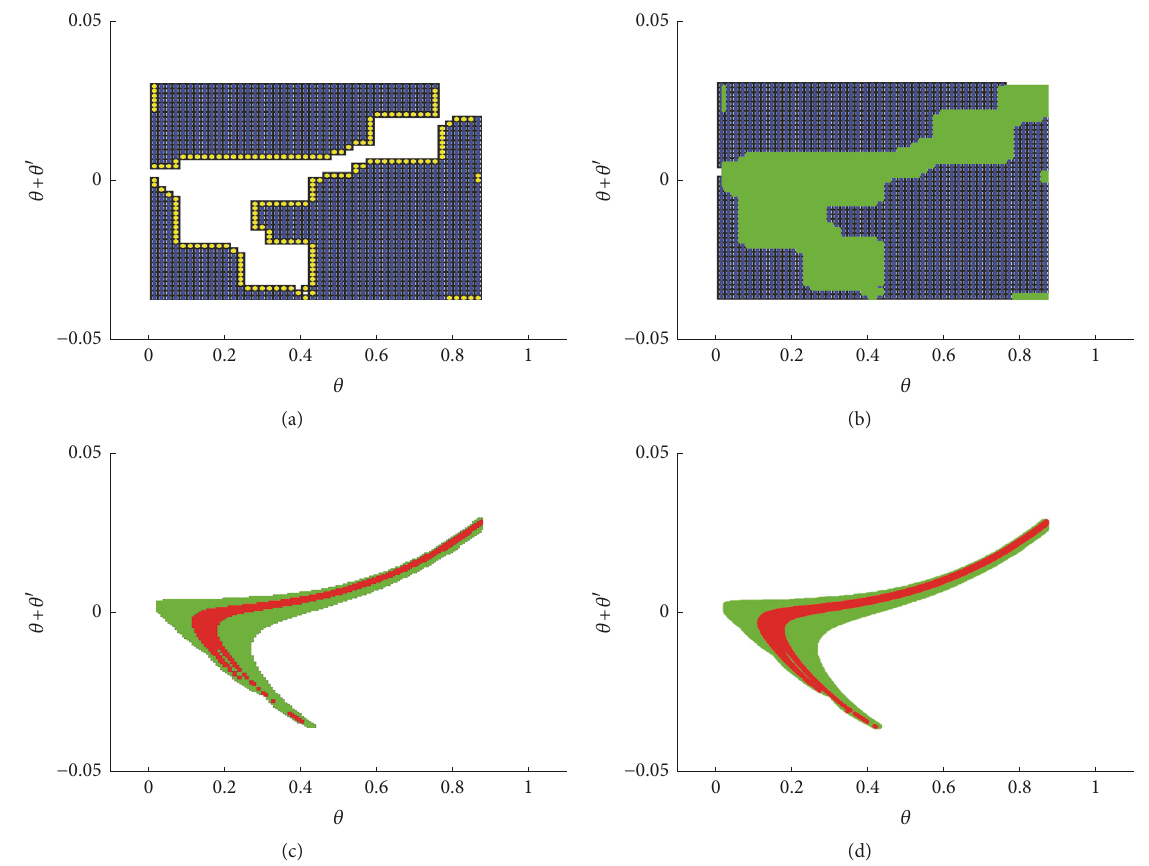
Figure 7: The processes of estimating the DOA of SPBW by the MICM method with boundary refinement. (a) The boundary cells in the stable DOF; (b) approximate DOC and stable DOF; (c) initial DOA and initial DOC; (d) the stable DOA and its corresponding DOC.